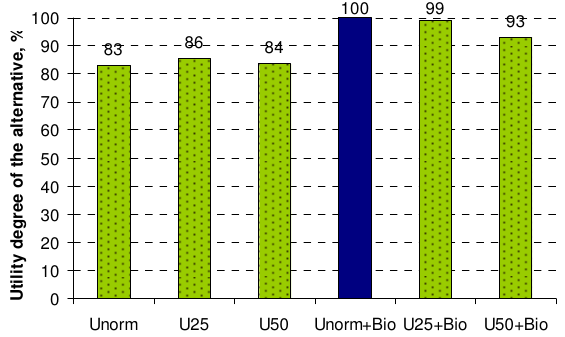
Fig. 4. Results of multi-criteria